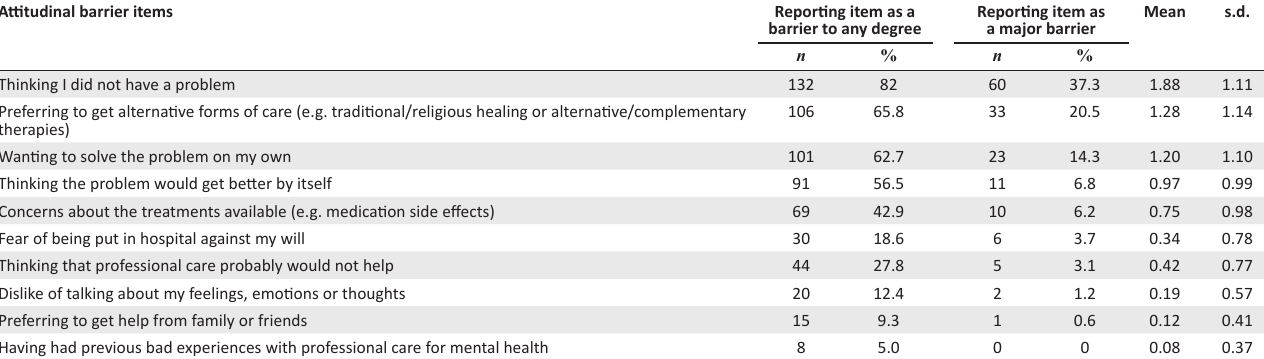
TABLE 4: Attitudinal barriers.